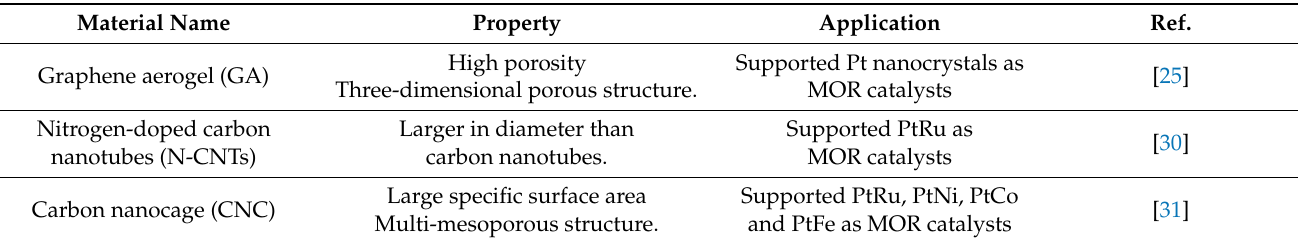
Table 1. Application of carbon materials in